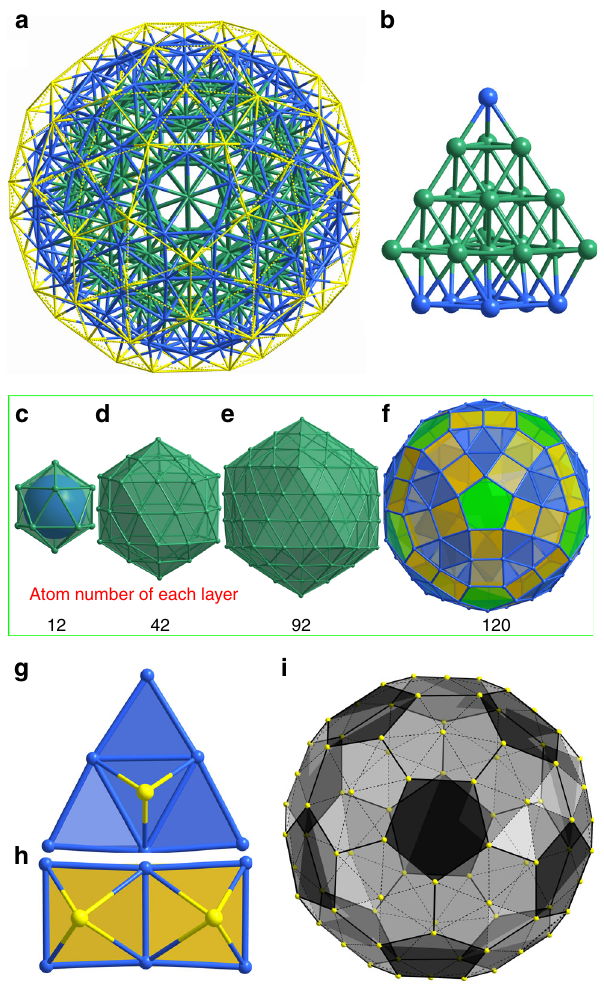
analysis indicate that the sizes of (AuAg) 267 and (AuAg) 45 are 1.65 nm (Supplementary Fig. 3) and 1.05 – 1.25 nm (Supplemen-